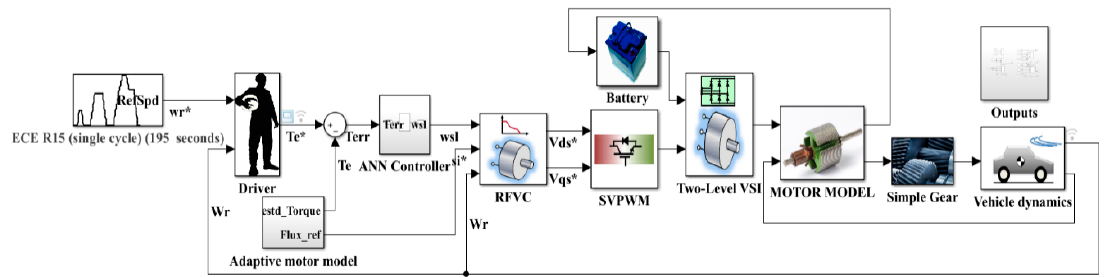
Figure 16. Simulink model of an ANN based direct torque controlled eCAR propulsion system.